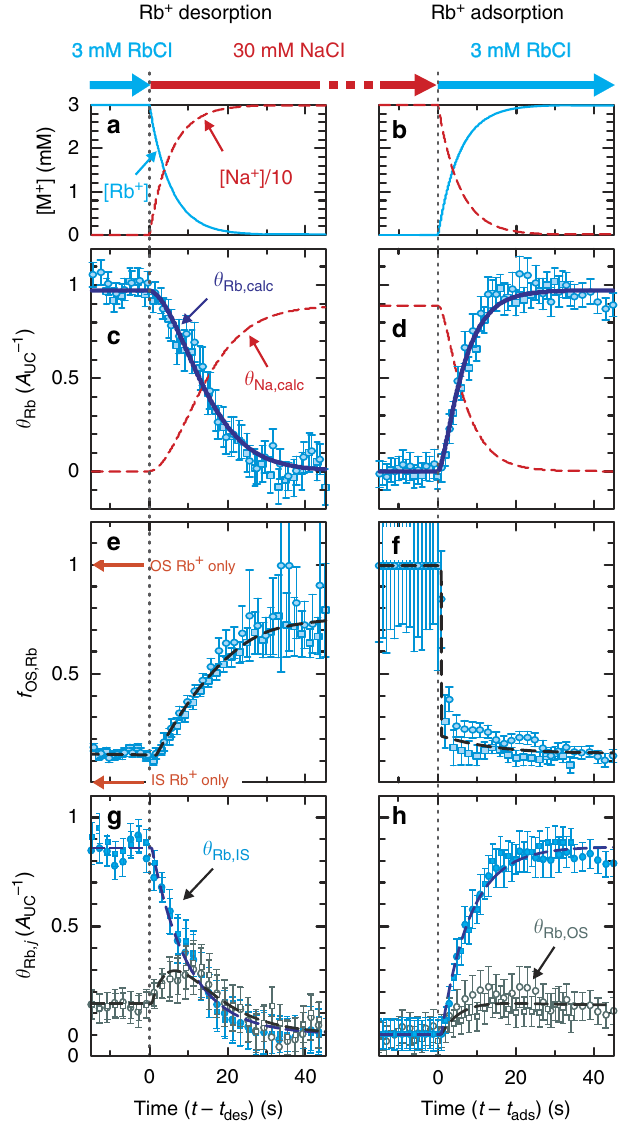
Figure 4 | Temporal changes in the coverage and speciation of Rb þ adsorbed at the muscovite mica (001)–water interface during desorption and adsorption. ( a , b ) The calculated concentrations of Rb þ and Na þ in the experiment cell (see Supplementary Notes 1 and 2 for details). ( c , d ) Temporal variations in the total Rb þ coverage ( y Rb ) during Rb þ desorption and adsorption. Each data set was duplicated (circle and square symbols). The thick solid blue lines represent the total Rb þ coverage ( y Rb,calc ) calculated from the best-fit model (Table 1). The variations of Na þ coverage ( y Na,calc ) calculated from the same model are also plotted in red dashed lines for comparison. ( e , f ) Temporal variations in the fractional coverage of OS Rb þ ( f OS,Rb ¼ y Rb,OS / y Rb ) during desorption and adsorption. ( g , h ) Variations in the coverages of individual Rb þ species ( y Rb, j where j ¼ IS or OS) were calculated as y Rb,IS ¼ y Rb (1 (cid:2) f OS,Rb ) and y Rb,OS ¼ y Rb f OS,Rb . The error bars represent s.d. uncertainties of the parameters derived from the least-squares analysis. The dashed lines are included to guide the